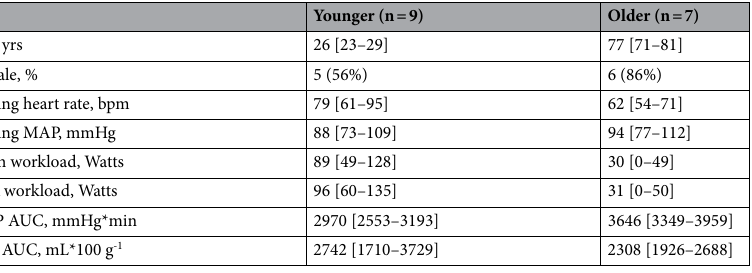
Table 2. Demographics and proof-of-concept for the primary outcome measure of cerebral blood flow area under the curve. Values mean [range] unless otherwise noted. AUC measures are cumulative over the 34:48 min of MRI CBF acquisition. Bpm beats per minute, mmHg millimeters of mercury, CBF cerebral blood flow, MAP mean arterial pressure, AUC area under